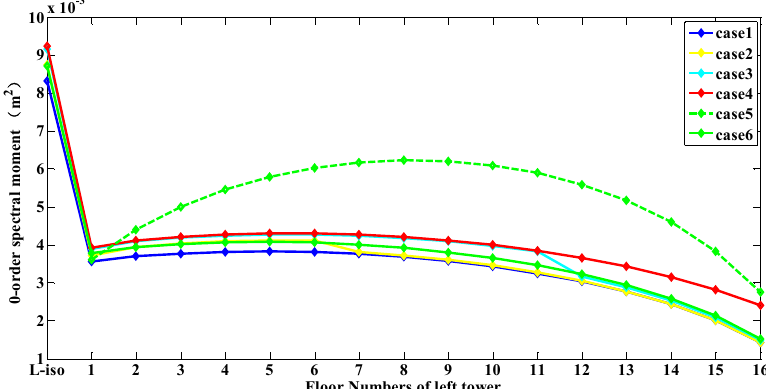
11 of 18 Figure 10. Second-order spectral moment of displacement of each layer of the podium . It can be seen from Figures 11 and 12 (where L-iso represents the isolation layer) that